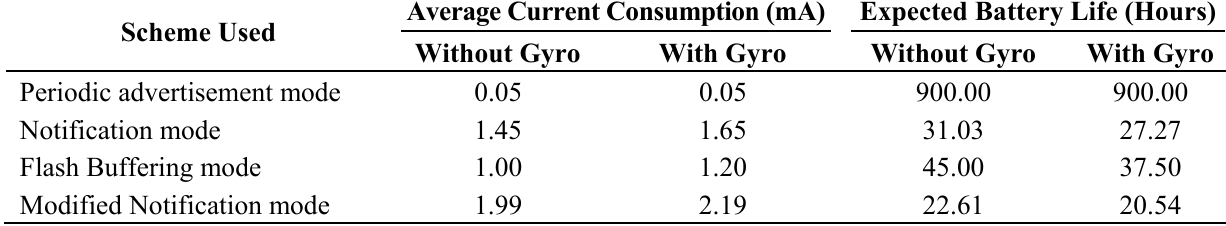
Table 1. Power test results, average current consumption and expected battery life for different